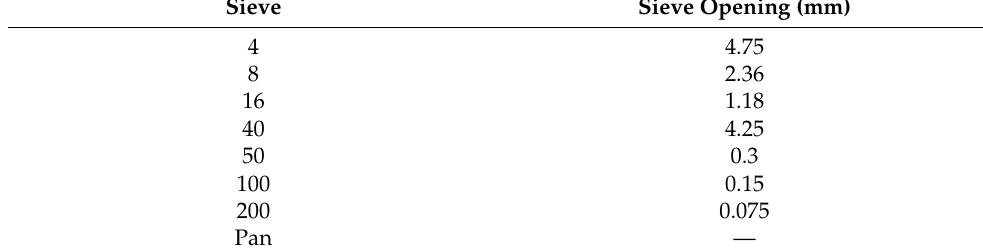
Table 1. List of sieves and their opening diameter in (mm).